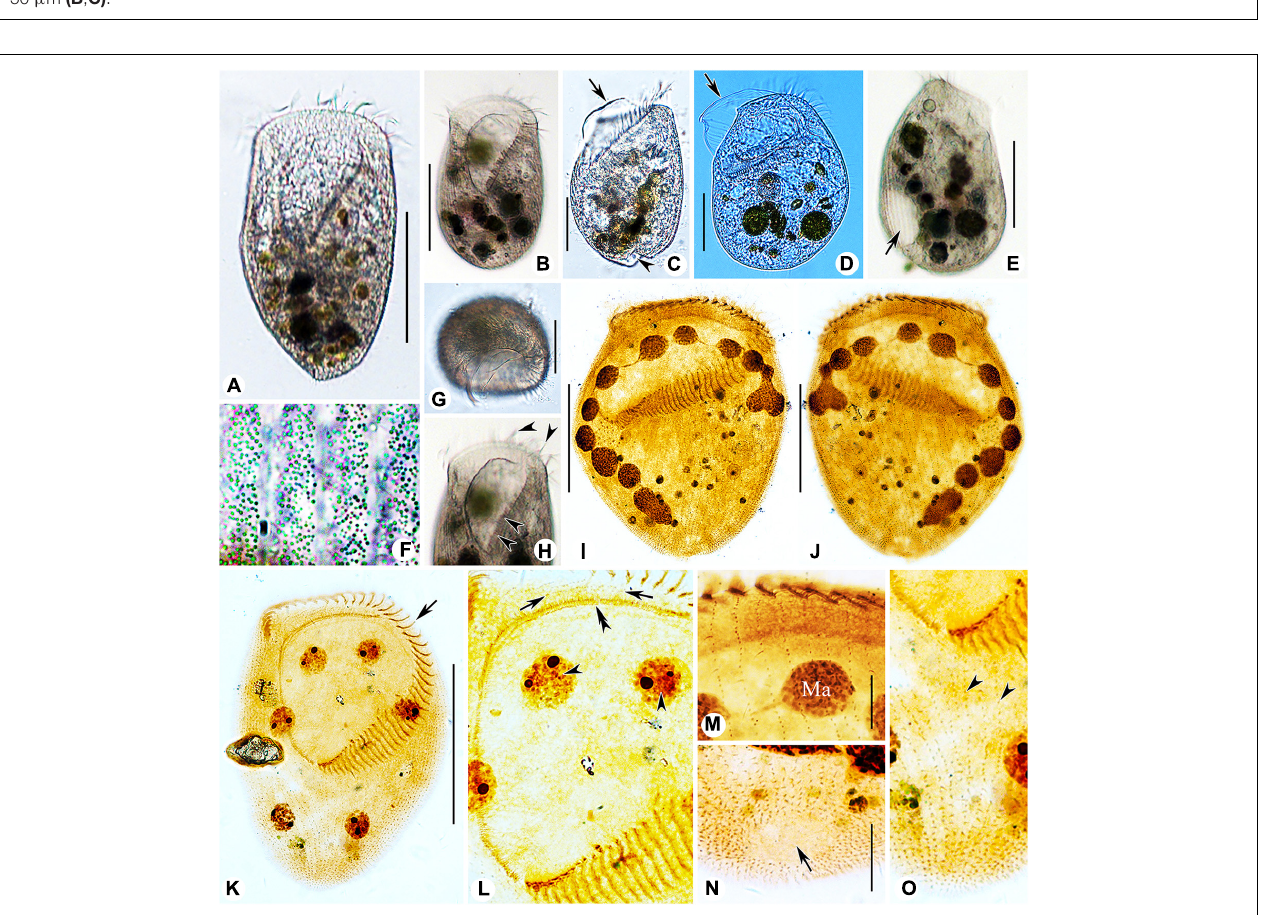
FIGURE 3 | Photomicrographs of Linostomella pseudovorticella n. sp. (A–H) from life and (I–O) after protargol staining. (A , B) Ventral view of two typical individuals. (C , D) Left lateral view, showing the prominent paroral membrane (arrows) and the depression at posterior end of body (arrowhead). (E) Right lateral view, showing the contractile vacuole (arrow). (F) To show the arrangement of the small cortical granules. (G) Apical view of an individual. (H) Anterior region of cell, arrowheads indicate the adoral zone of membranelles. (I , J) Ventral (I) and dorsal (J) view of the infraciliature of the holotype specimen. (K) Ventral view of the infraciliature; arrow indicates the adoral zone of membranelles. (L) Detail of oral area; double arrowhead indicates the paroral membrane, arrows indicate the short kineties, and arrowheads indicate the macronuclear nodules. (M) Anterior portion of dorsal view of the cell. (N) Dorsal view showing glabrous area at posterior end of cell (arrow). (O) Ventral view of posterior portion of cell; arrowheads indicate the short somatic kineties. Abbreviation: Ma, macronucleus. Scale bars = 100 µ m (A , B , E , I–K) , 50 µ m (C , D , G) , and 20 µ m (M , N) .